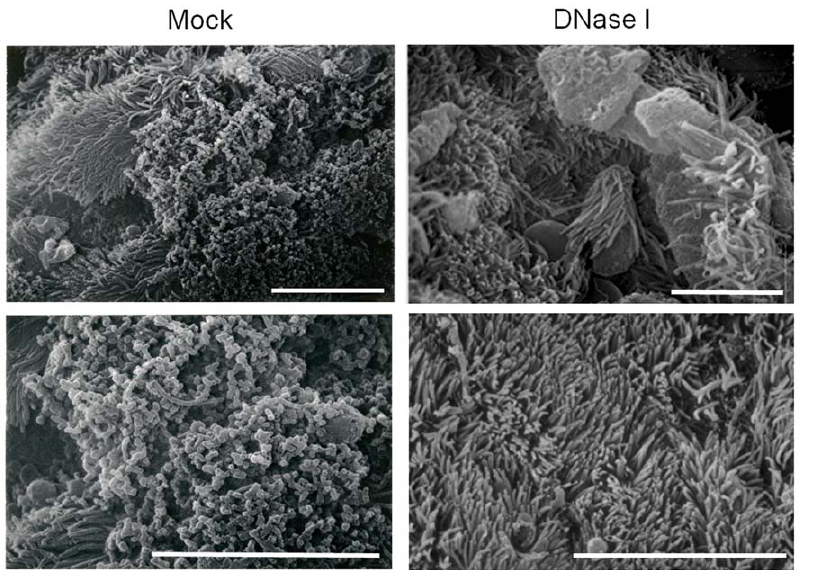
Figure 7. Scanning electron microscopy of mock treated (left) or DNase I treated Bordetella biofilms formed in the mouse nose. Nasal septa were harvested from mice 15 days post-inoculation, excised into two equal parts, treated with either the DNase I buffer (Mock, left panels) or DNase I (right) followed by processing for SEM as described in the Materials and Methods.